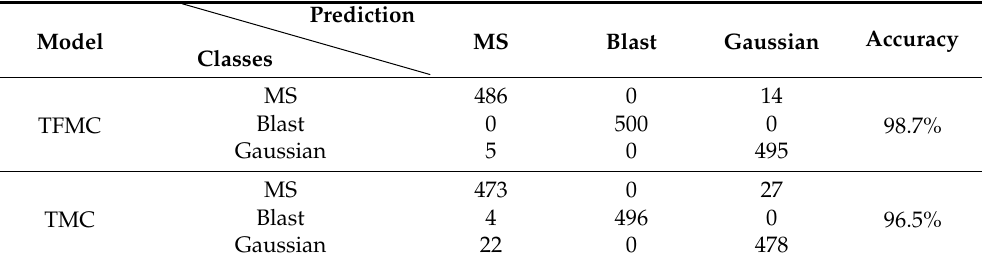
Table 5. Confusion matrix of the test dataset of TFMC and TMC models. MS, Blast, and Gaussian represent the microfracture, blast, and gaussian noise signals, respectively. The overall accuracies of the TFMC and TMC methods are 98.7% and 96.5%, respectively.